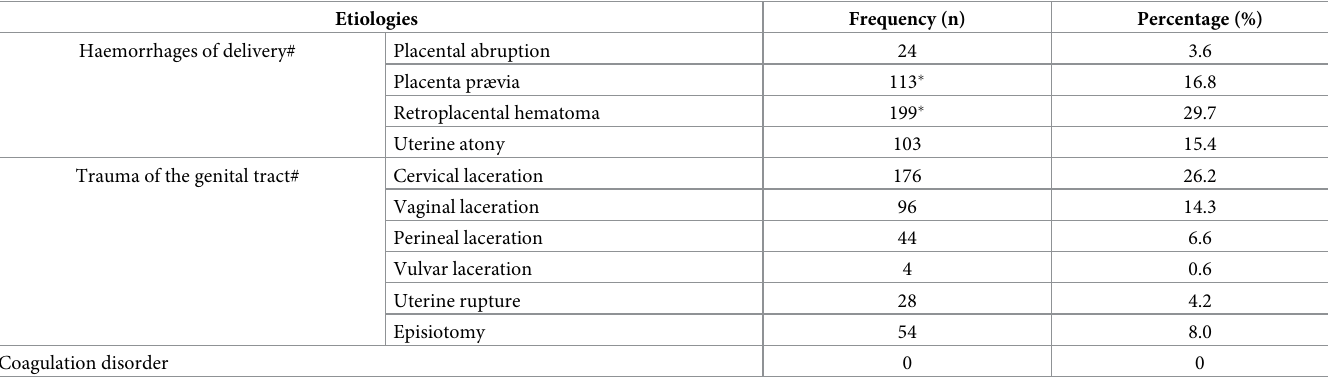
Table 3. Distribution of parturients by causes of primary postpartum